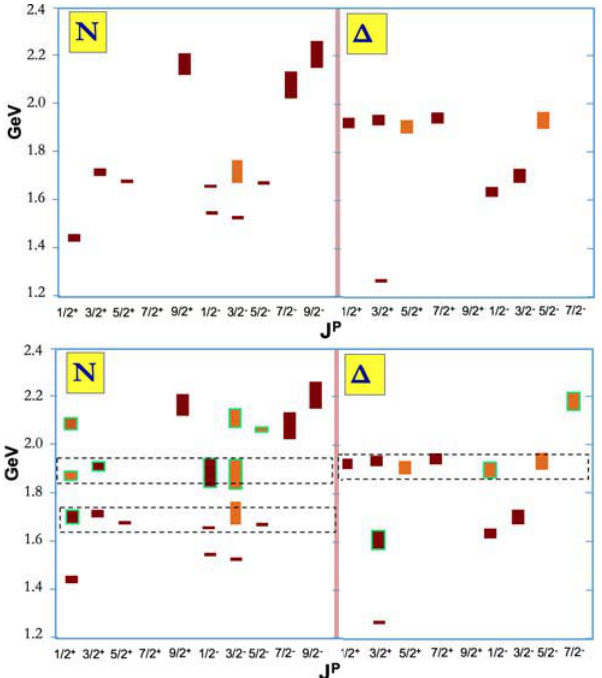
Fig. 5 Top panel: Nucleon and Δ resonance spectrum be- low 2.2 GeV in RPP 2010 [9]. Bottom panel: Nucleon and Δ resonance spectrum below 2.2 GeV in RPP 2018 [12]. The green frames highlight the new states and states with im- proved start ratings compared to 2010. The light brown color indicate 3* states, the dark color indicates 4* states. The dashed frames indicate apparent mass degeneracy of states with masses near 1.7 GeV and 1.9 GeV and different spin and parity. The Bonn-Gatchina analysis includes all the K + Λ and K + Σ ◦ cross section and polarization data, as well as pion photoproduction